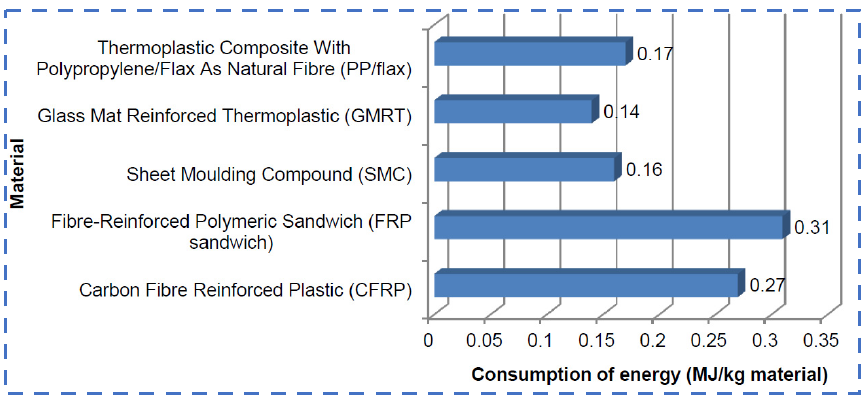
Figure 14. Consumption of energy in grinding of composites [146].